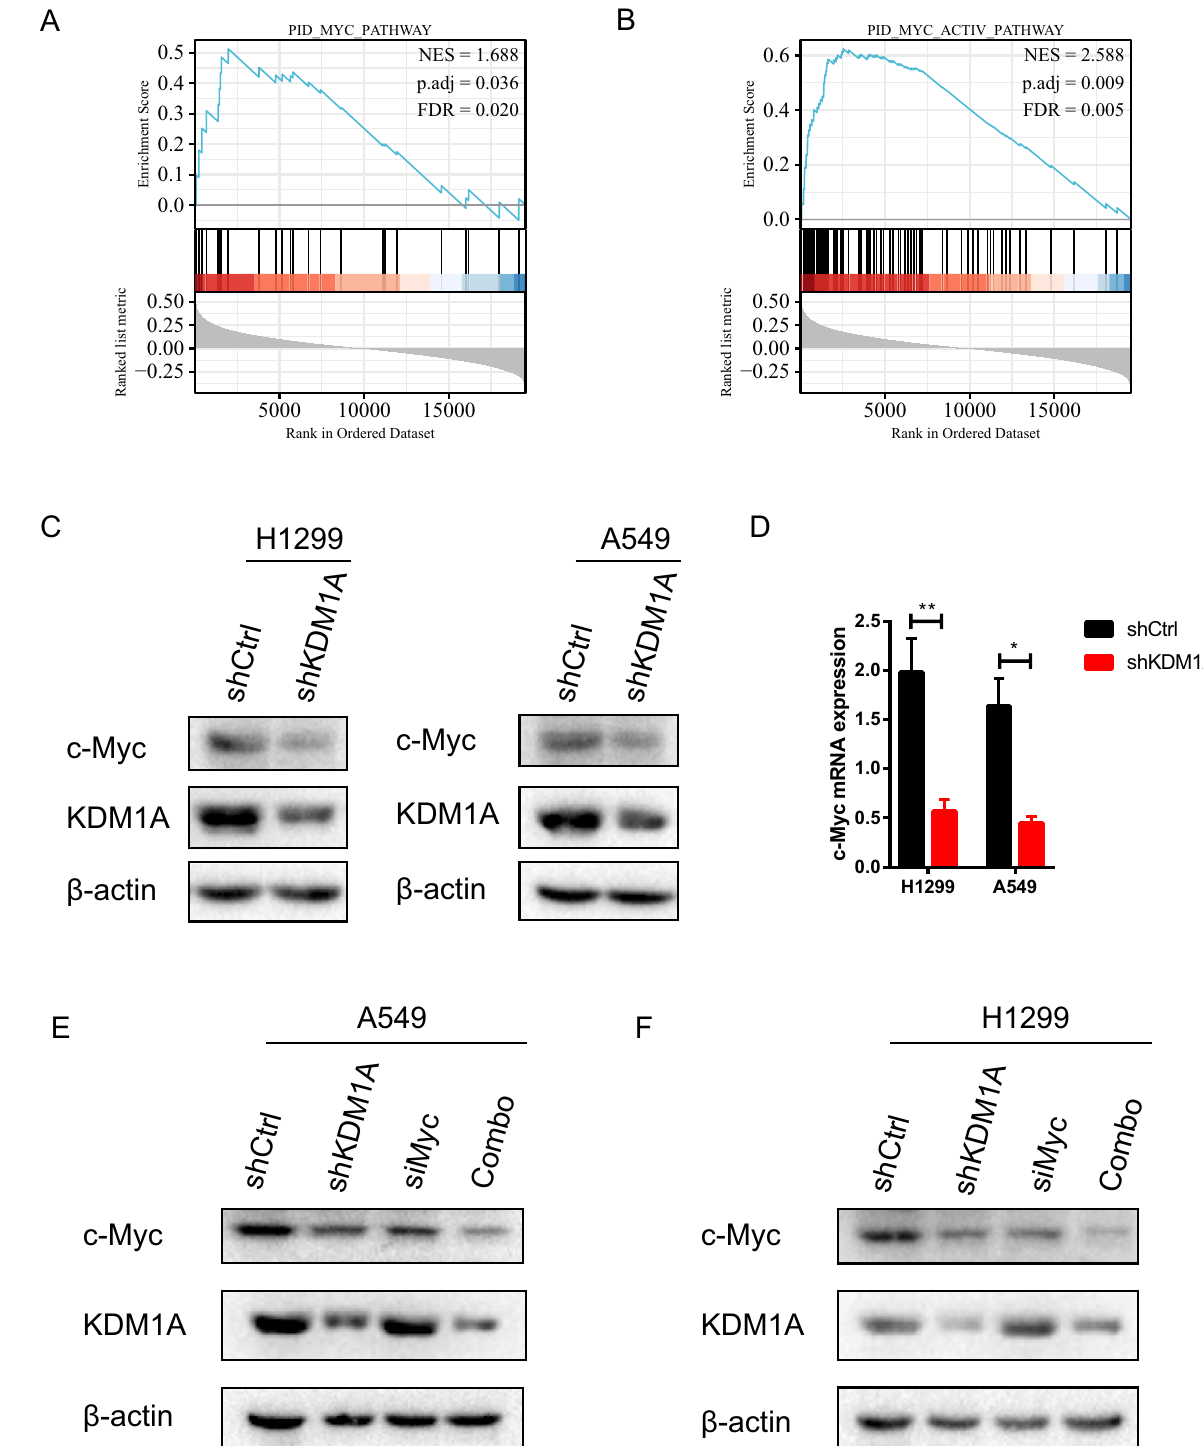
Figure 4. KDM1A knockdown repressed c-Myc expression. ( A , B ) The GSEA pathway analysis revealed that KDM1A co-expressed genes might regulate the Myc signaling. ( C , D ) The c-Myc protein and mRNA levels were explored in H1299 and A549 stable cell lines with KDM1A knockdown. According to the molecular weight, the nitrocellulose membrane was cut prior to hybridization with antibodies and the original blots are presented in Supplementary Fig. 8. ( E , F ) The combination treatment of KDM1A knockdown and c-Myc knockdown synergistically inhibited c-Myc expression in H1299 and A549 cells. According to the molecular weight, the nitrocellulose membrane was cut prior to hybridization with antibodies and the original blots are presented in Supplementary Fig.